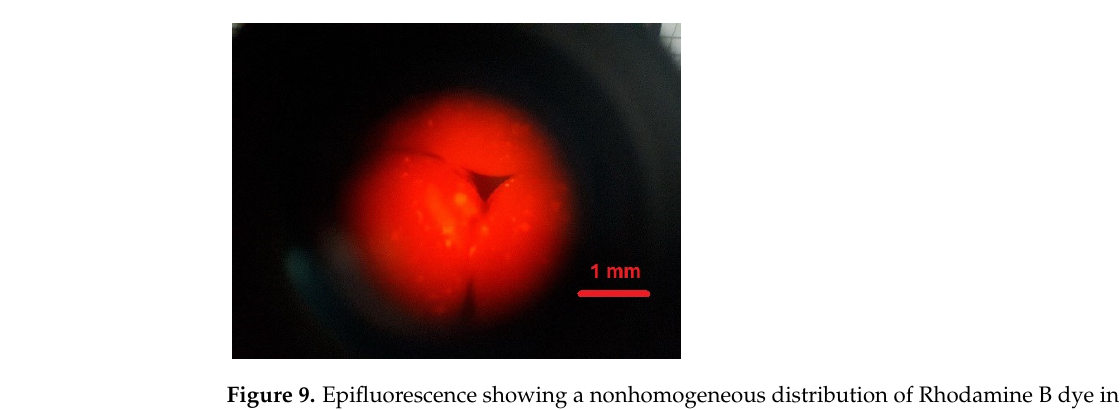
Figure 8. HFBMA NPs in a chitosan hydrogel bead.